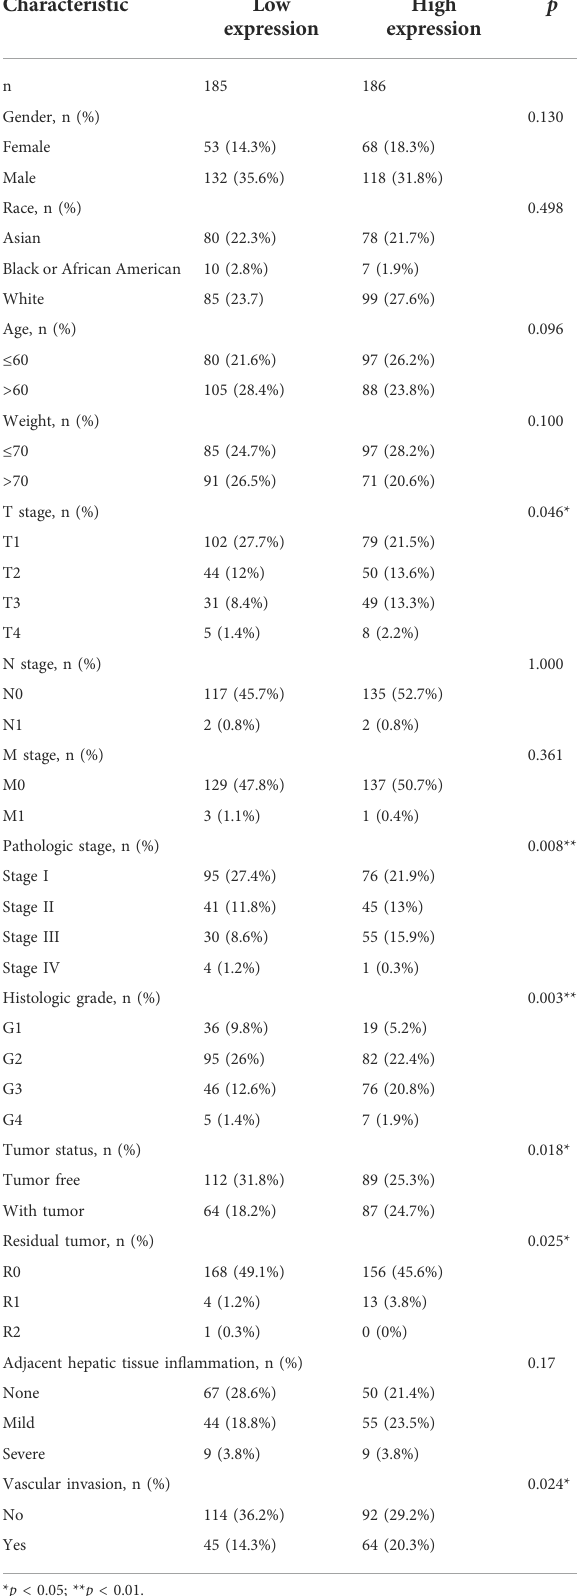
TABLE 1 Correlation between CAMSAP1 expression and clinical variables in LIHC based on TCGA